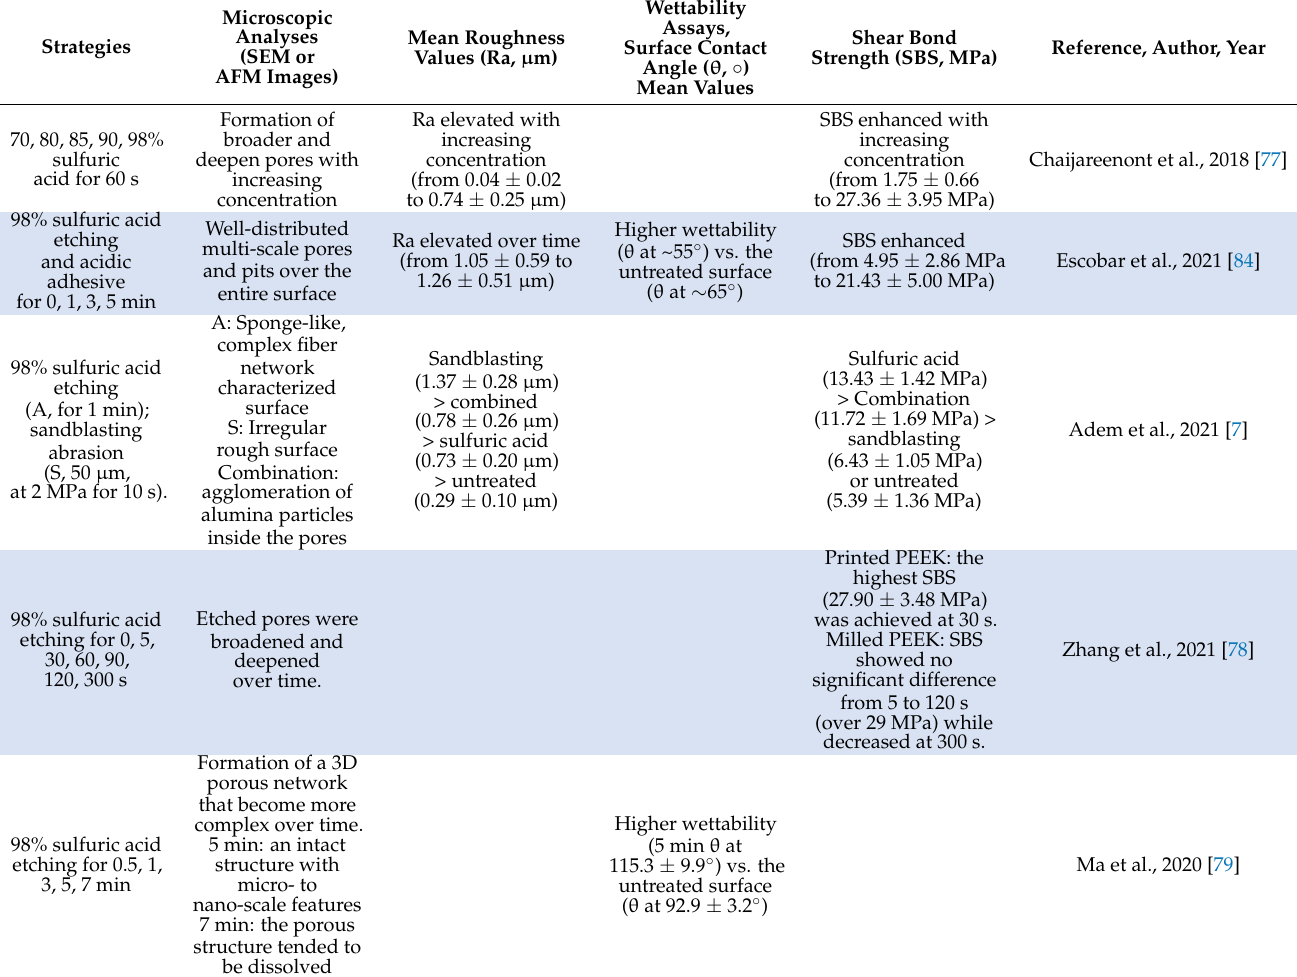
Table 2. The application of acid etching for the improvement of PEEK adhesion